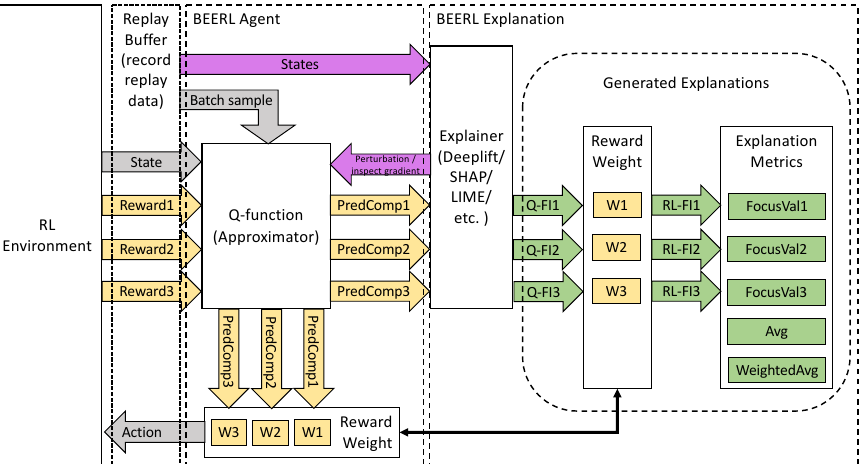
Figure 2. Illustration of BEERL dataflow in generating explanations in two different levels. The BEERL explanations are shown by green color while reward decomposition elements as introduced in [7] are shown by yellow; feature important components are shown by purple; common RL components are shown by grey.